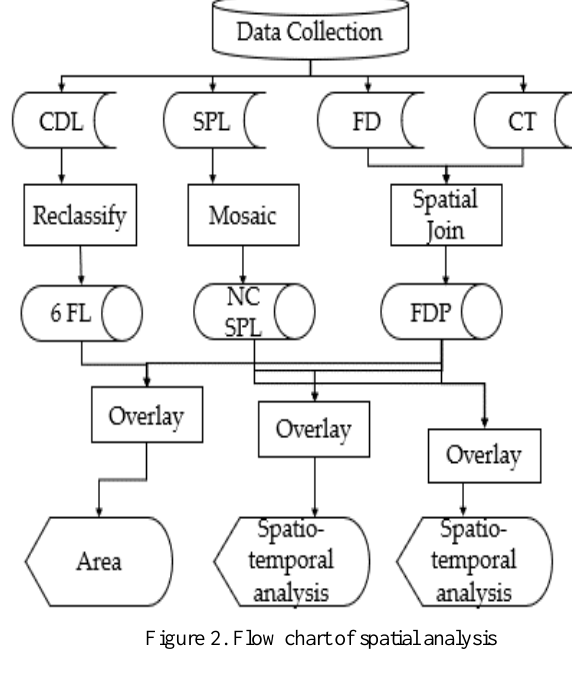
Figure 2. Flow chart of spatial